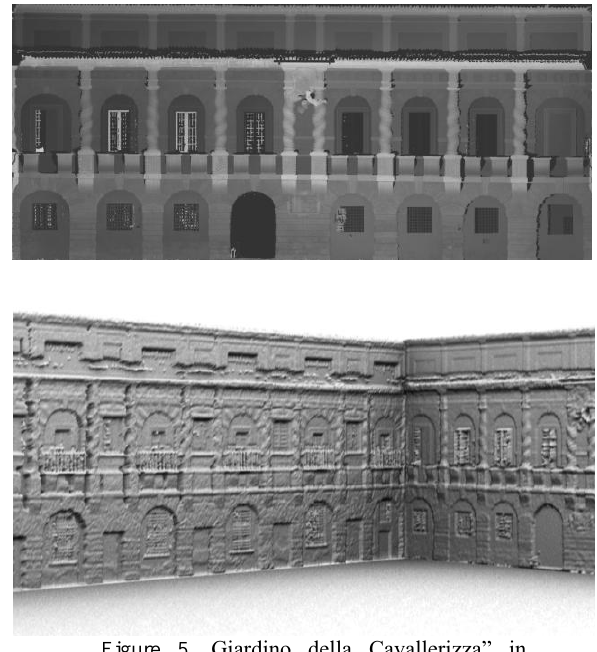
Figure 5. Giardino della Cavallerizza” in Palazzo Ducale in Mantova. a) depth map b) 3d perspective view